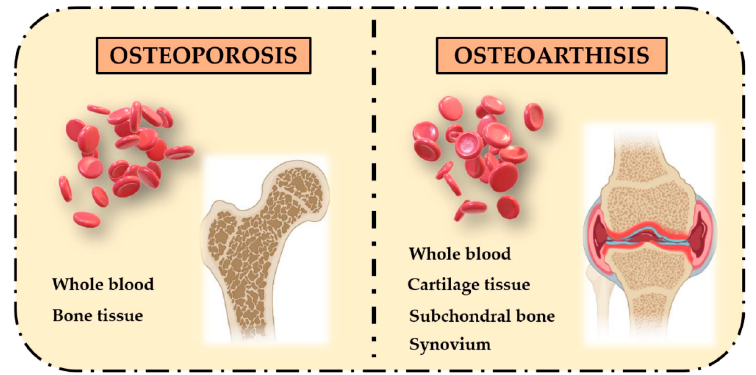
Figure 2. Different affected tissues in OP and OA bone-related phenotypes. OP pathogenesis mainly involves bone tissue, while OA pathogenesis involves multiple tissues, including cartilage, subchondral bone and